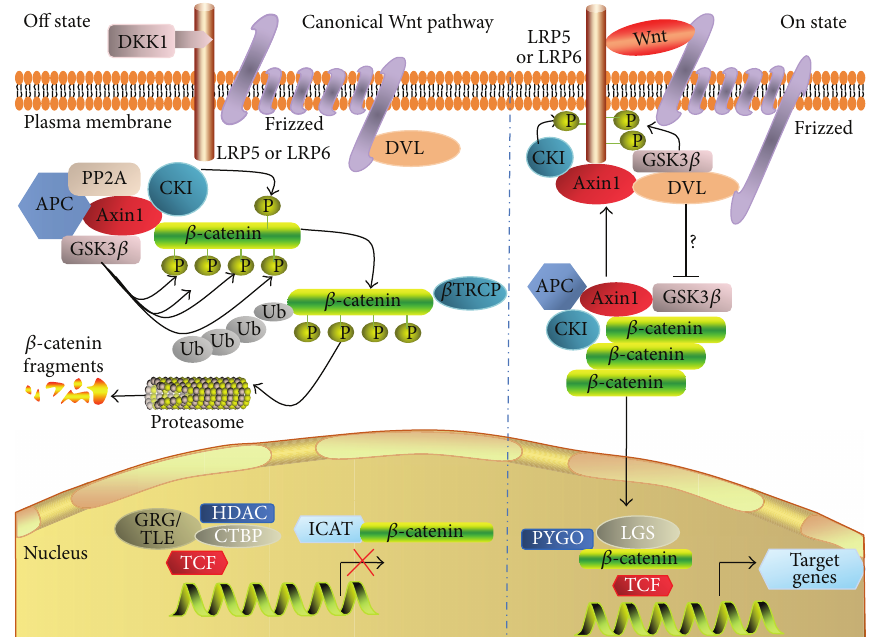
Figure 1: Canonical Wnt signaling pathway ( 𝛽 -catenin-dependent Wnt signaling pathway). In the absence of Wnt ligand(s), cytoplasmic 𝛽 -catenin is targeted for phosphorylation, by a multiprotein complex comprising Axin, adenomatous polyposis coli (APC), the glycogen synthase kinase 3 𝛽 (GSK3 𝛽 ), and casein kinase 1 𝛼 (CK1 𝛼 ). The phosphorylated form of 𝛽 -catenin is recognized by an E3 ubiquitin ligase ( 𝛽 -TrCP) and then targeted to proteasomal degradation, resulting in low cytosolic levels (left panel); in the presence of Wnt ligand(s), Wnt ligand binds to the Fzd and LRP receptors, and this binding triggers the signaling and activates the Dvl; the activation of Dvl inhibits the GSK-3 𝛽 and results in destructing the multiprotein complex which stabilizes and leads to the intracellular accumulation of 𝛽 -catenin in the cytoplasm; accordingly the active 𝛽 -catenin translocates to the nucleus, where it acts as a transcriptional coactivator with TCF/LEF to activate Wnt-responsive target genes (right